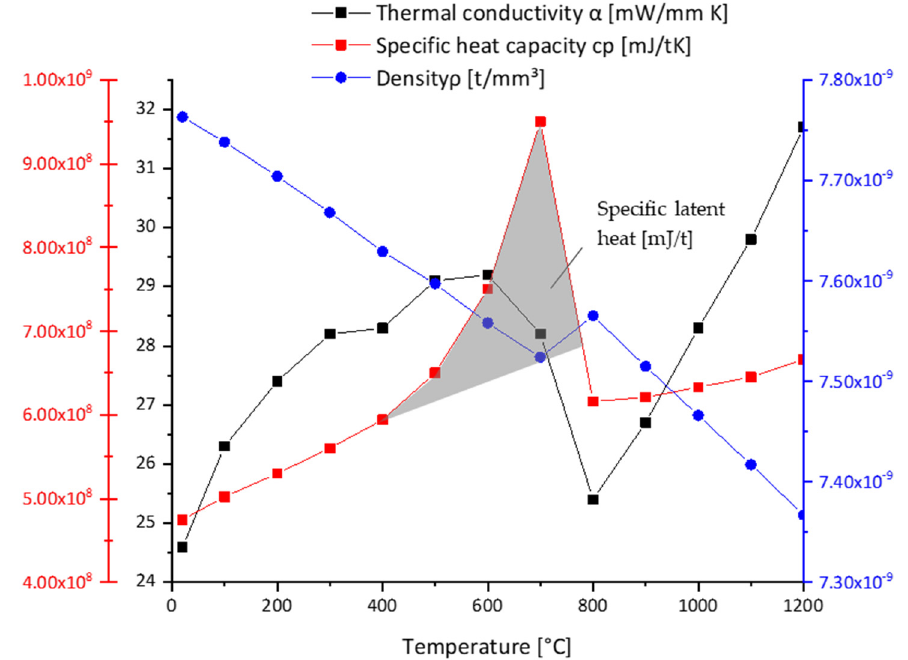
Figure 3. Specific heat ( c p ), latent heat, density ( ρ ) and thermal conductivity ( α ) over temperature.